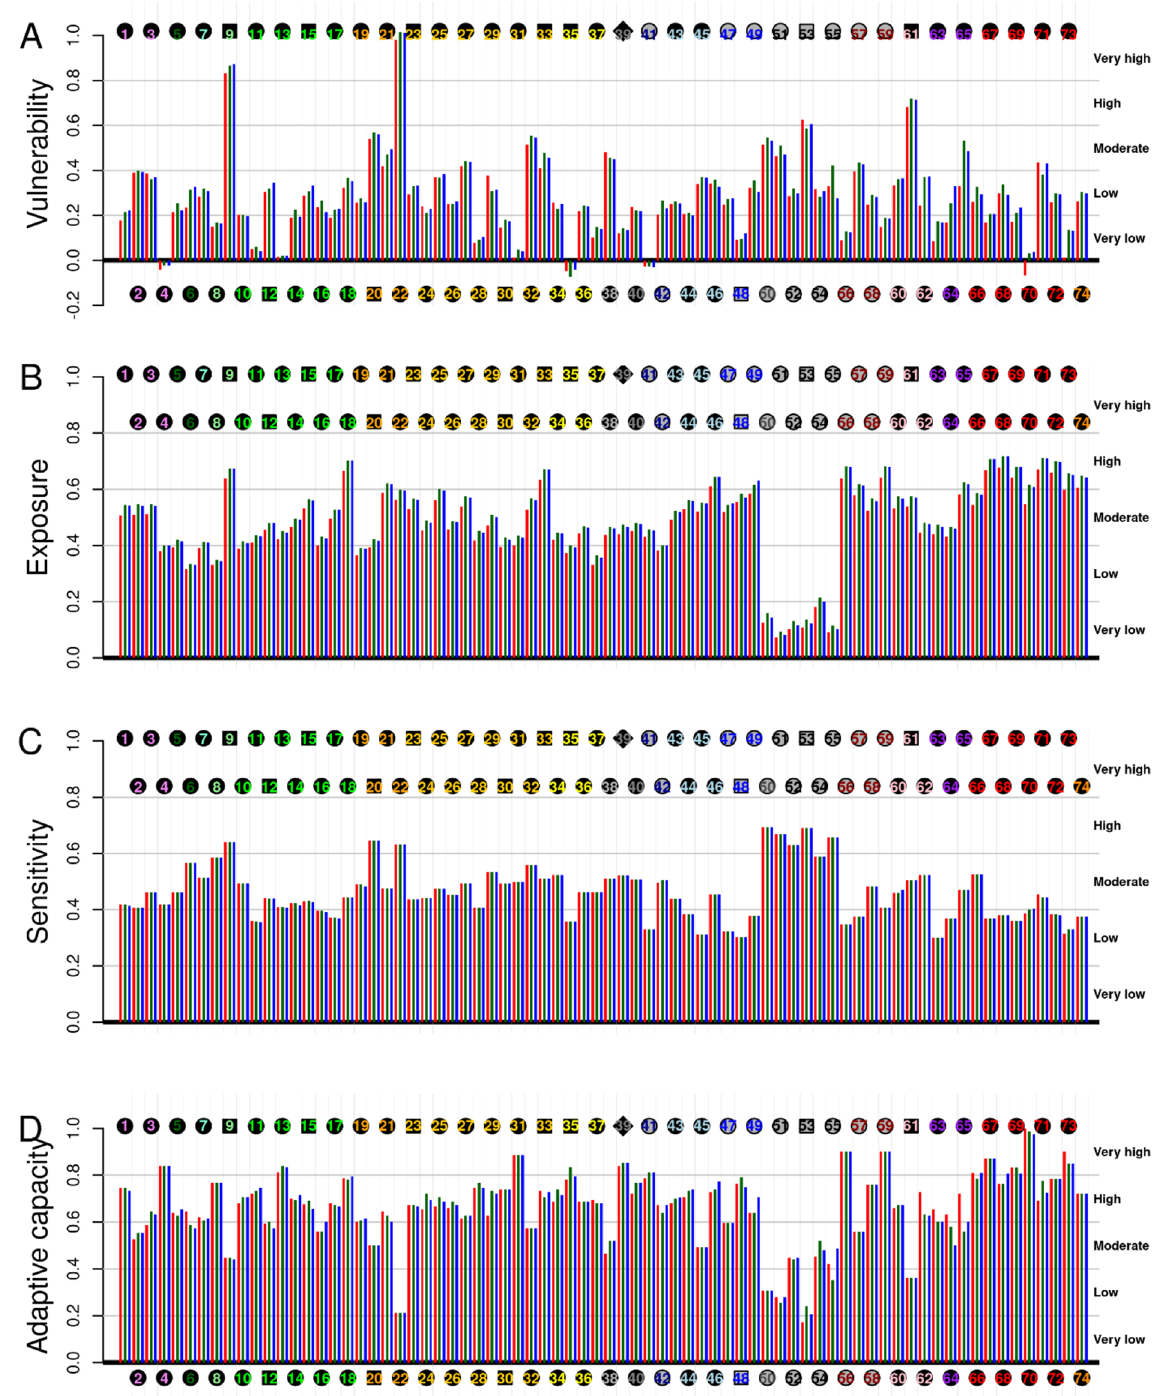
Figure 2. Expert-based assessments of overall vulnerability, exposure, sensitivity, and adaptive capacity for the 74 species under study under climate change scenario RCP 8.5. Species are identified by the species number as in Table 1, and functional groups are represented by the colour of the species number. For each assessment, column colours represent the region (red: North, green: Centre, blue: South). The vulnerability and each of its dimensions are classified in 5 bins (very low, low, moderate, high, and very high). The symbol of the points represents the confidence of the vulnerability assessment obtained during the bootstrap analysis: circle (very high), square (high), diamond